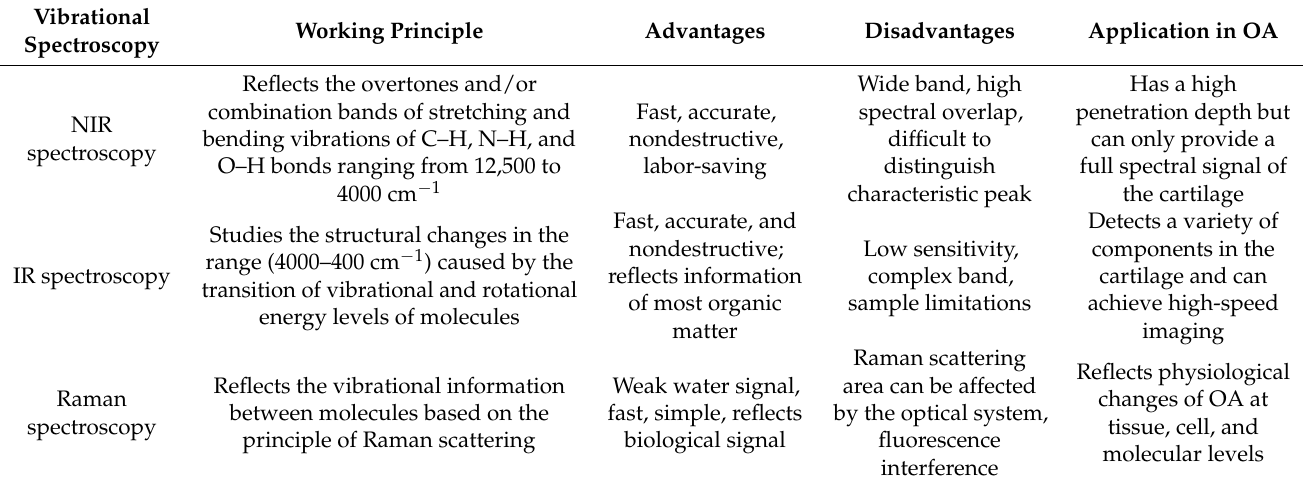
Table 2. Comparison table of application analysis of vibrational